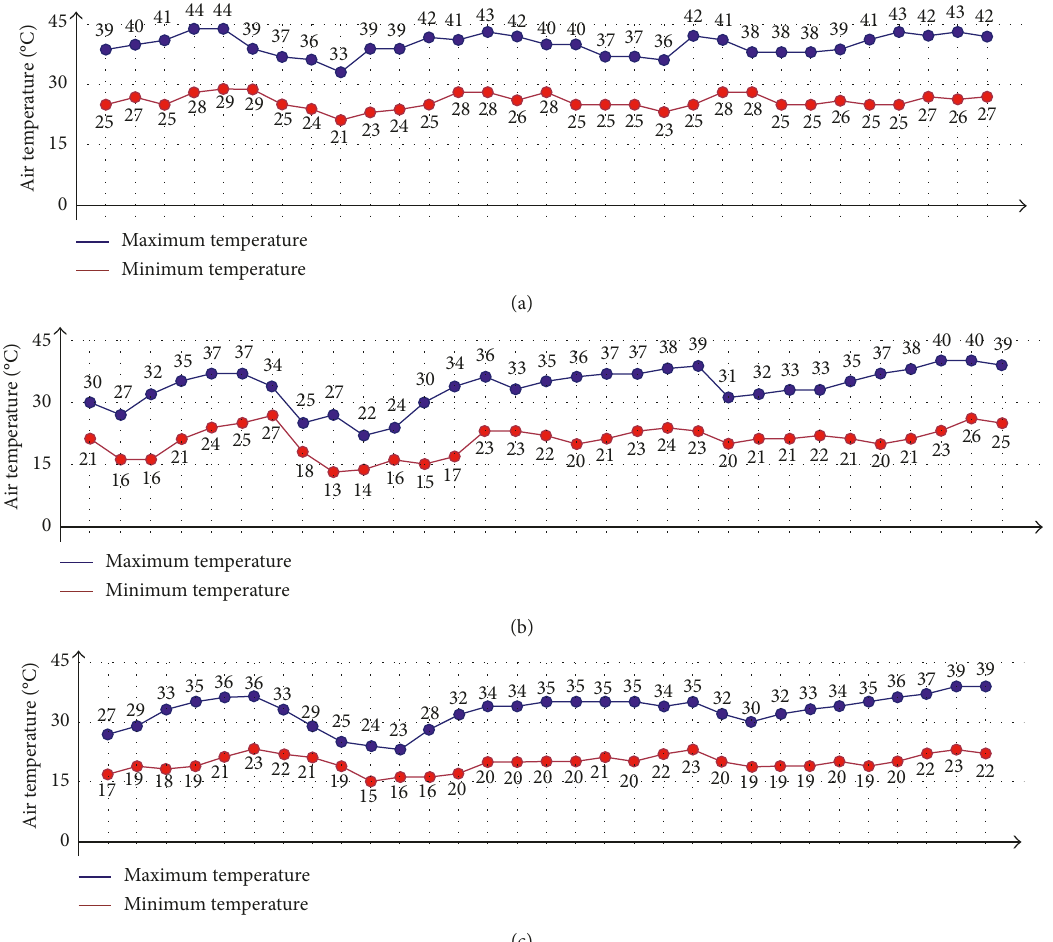
Figure 3: Daily temperature variation of southern Xinjiang in July 2013: (a) Turpan, (b) Khotan, and (c)